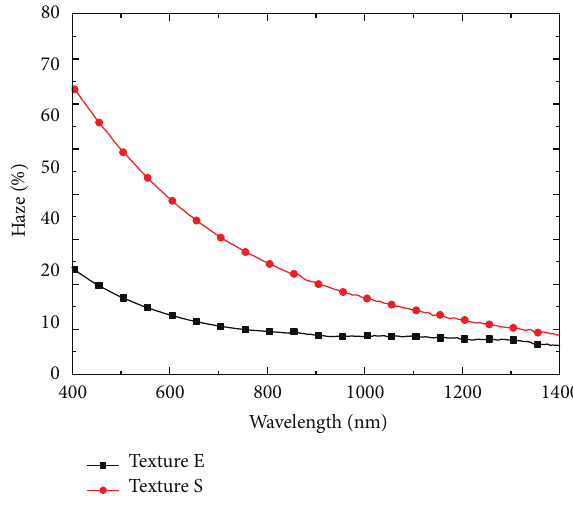
Figure 3: Haze of texture E and texture